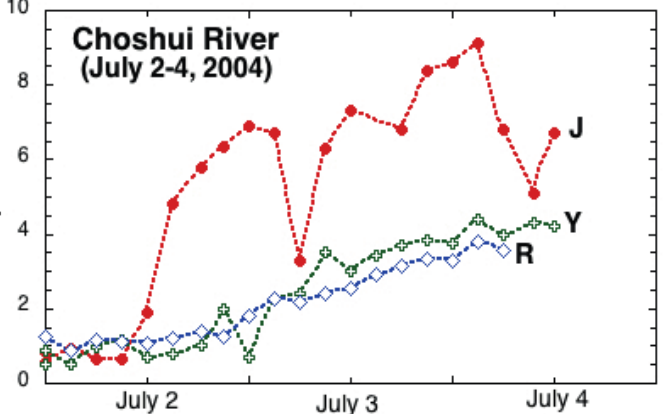
Fig. 13 Temporal and spatial variations in dissolved nitrate at Choshui River stations R, Y and J, 2–4 July 2004. Note the 8-fold increase in NO 3- at station J on 2